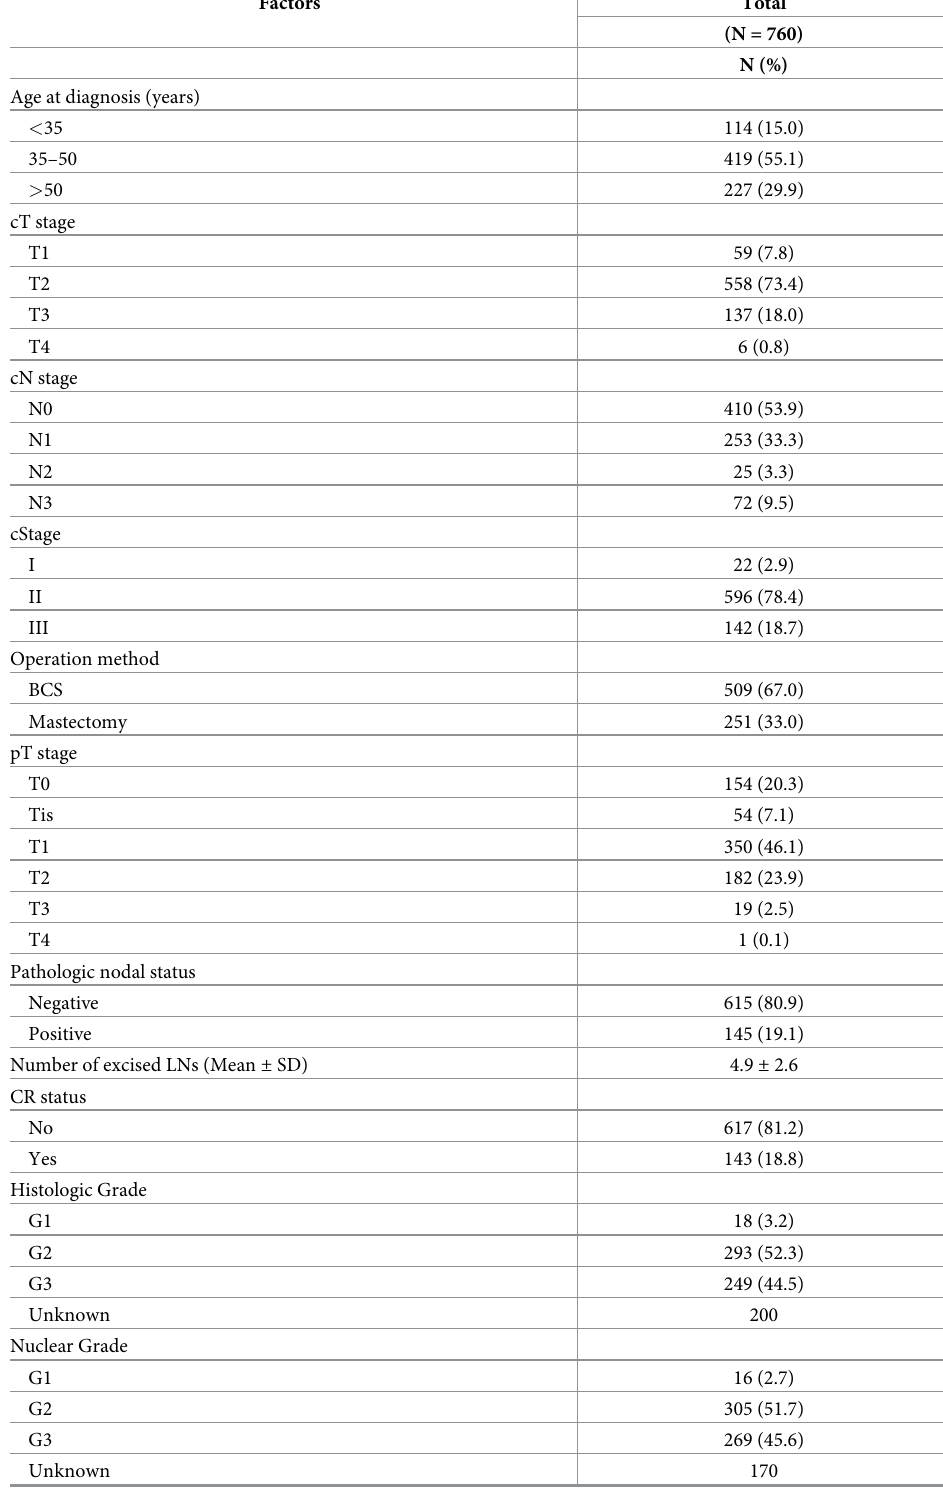
Table 1. Patient